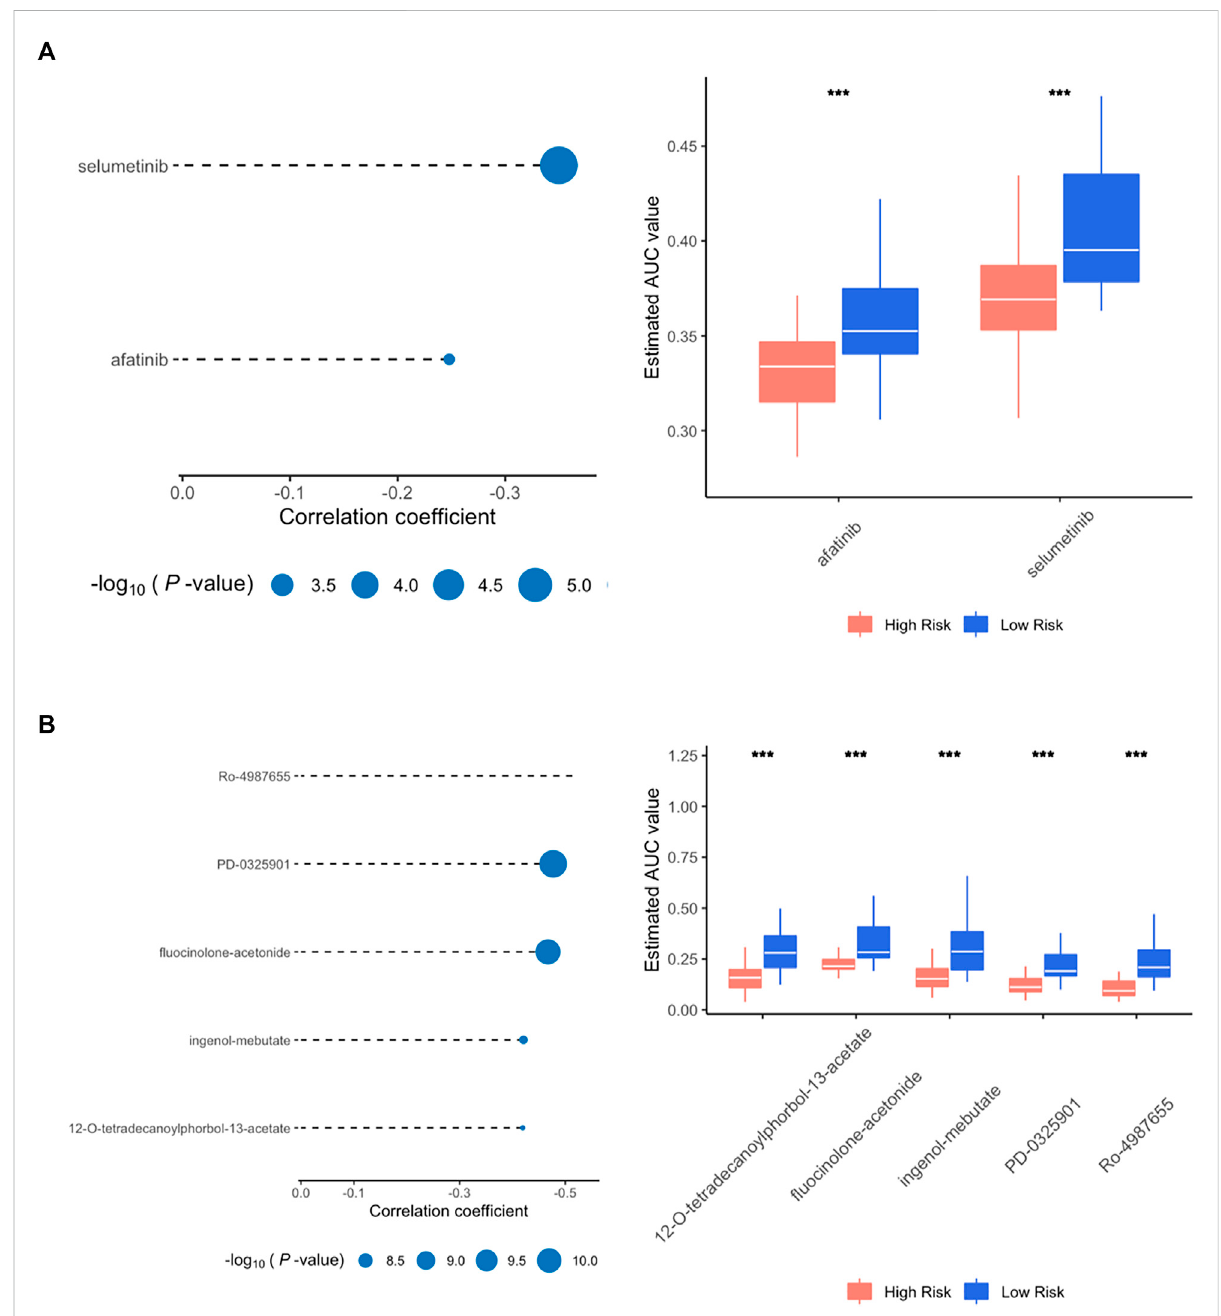
FIGURE 7 Spearmancorrelationanddifferentialdrugresponseanalysisforhighriskgroup. (A) Positivedrugsidenti fi edinCTRPdatabase. (B) Positivedrugs identi fi ed in PRISM